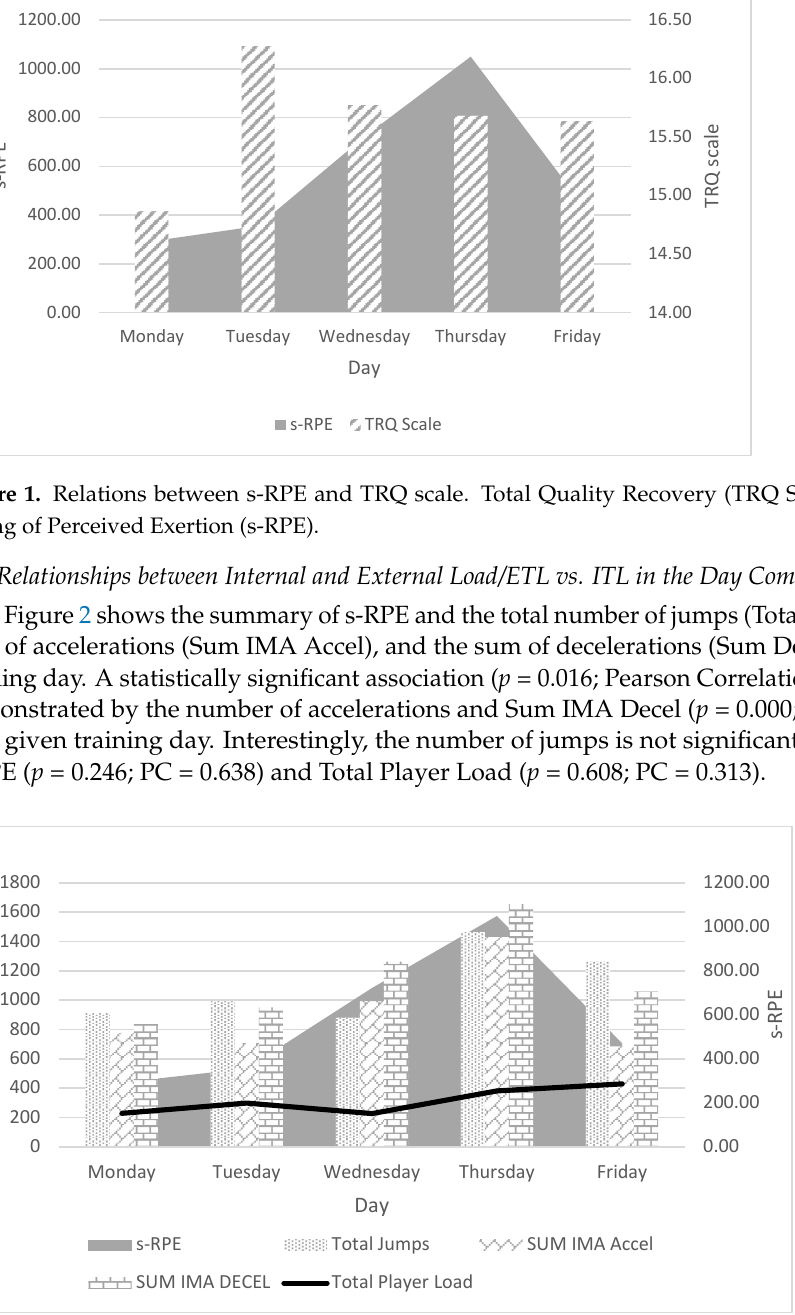
Figure 2. Correlations between s-RPE and ETL factors. Session Rating of Perceived Exertion (s-RPE), External Training Load (ETL), Inertial Movement Analysis Accel/Decel (IMA Accel/Decel).